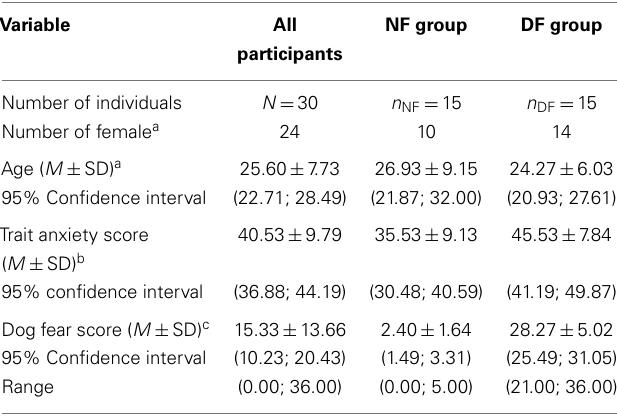
Table 1 | Participants’ characteristics